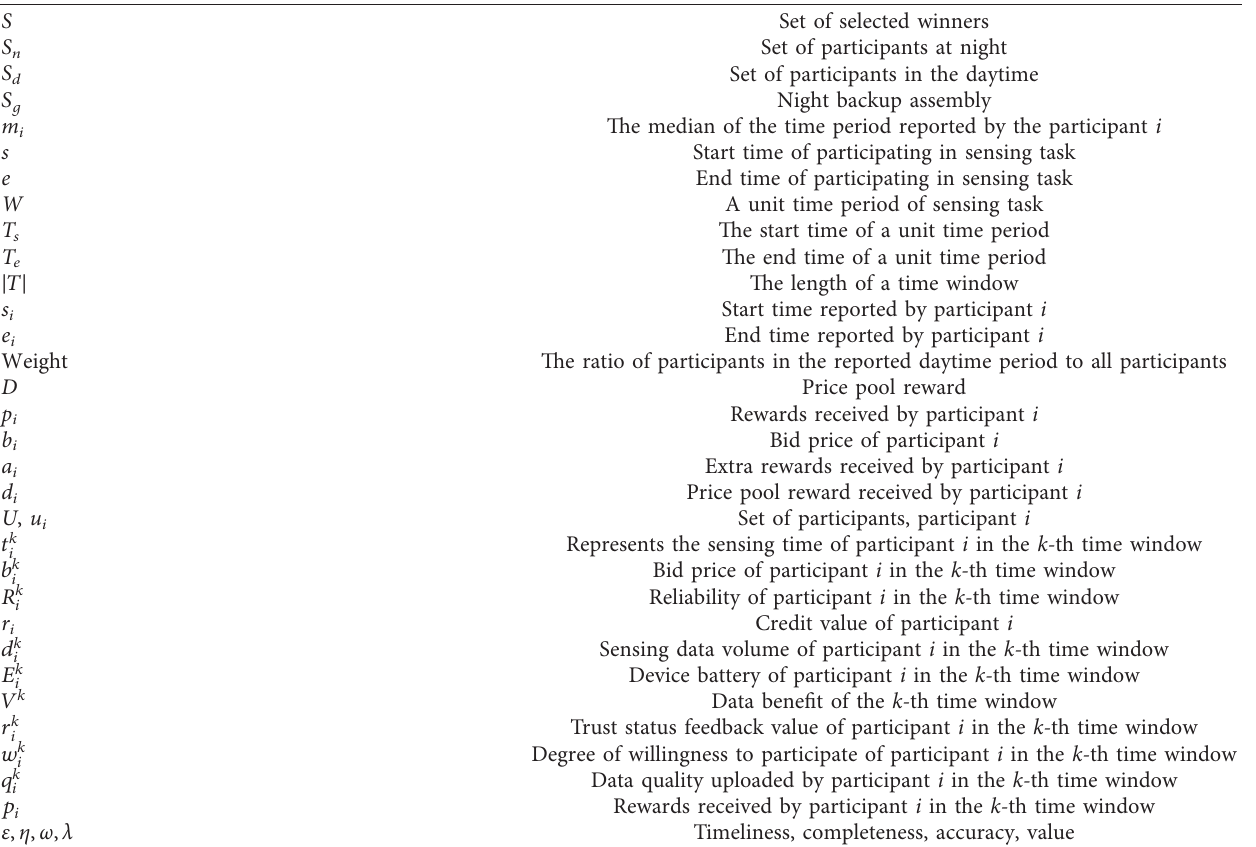
Table 1: Common parameters.